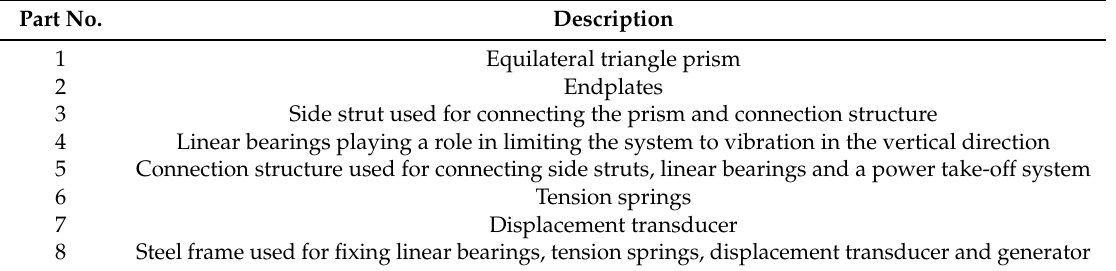
Table 1. Main components of the vibration system.